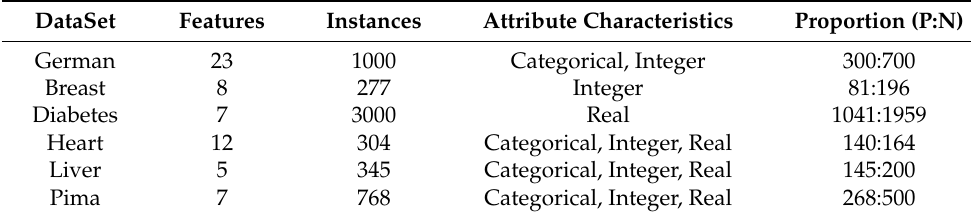
Table 1. DataSet.